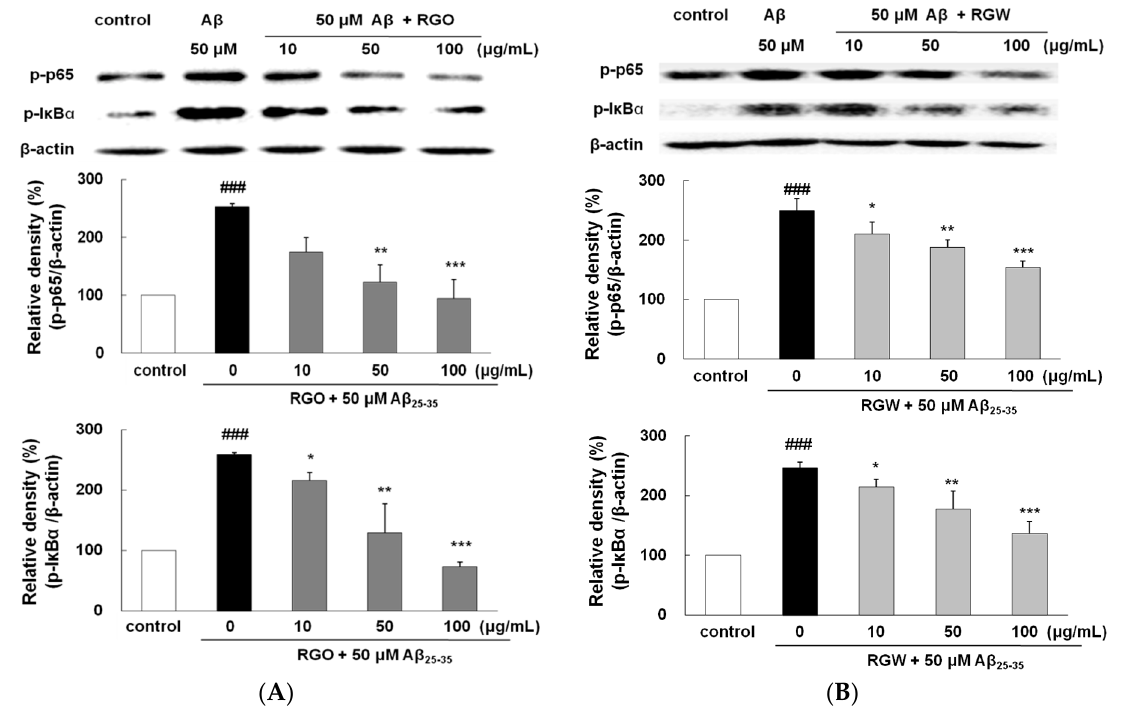
Figure 7. RGO ( A ) and RGW ( B ) blocked A β 25–35 -stimulated NF- κ B and I κ B α expression. PC12 cells were treated with A β 25–35 for 4 h and then cellular lysates were analyzed by Western blot assay. The separated proteins were analyzed by Western blot analysis as described in Materials and Methods.